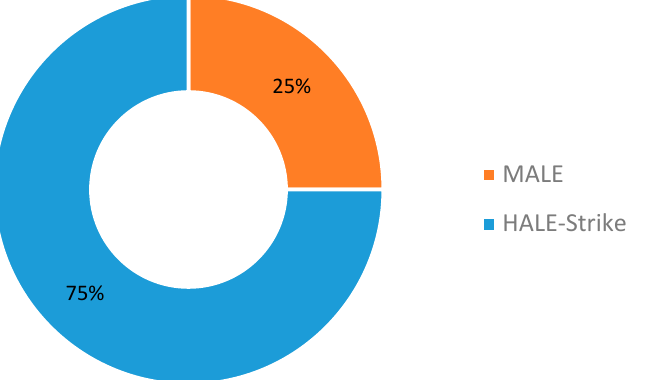
Figure 31. UAVs designed for low observability per NATO category.